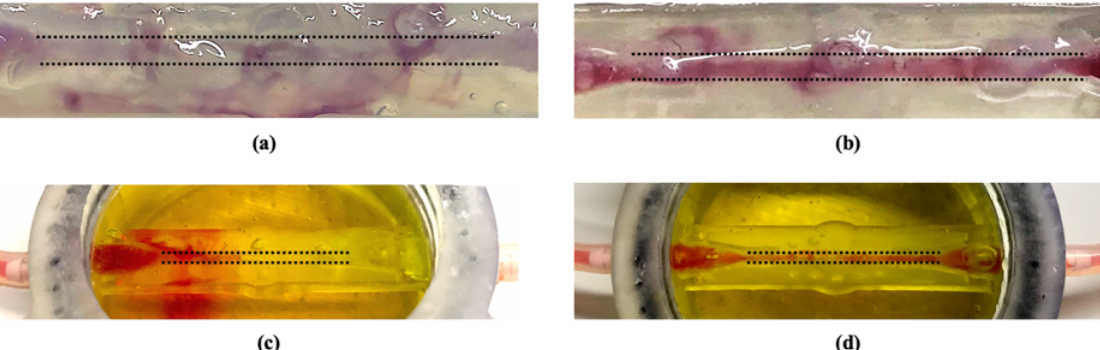
Figure 4. Hydrogels perfusion tests. The dotted line indicates where the channel is located. Comparison between alginate ( a ) and fibrin ( b ) capability to withstand the fluid passage at the same flow rate (1 mL / min); comparison between 3 mL / min ( c ) and 1.5 mL / min ( d ) as input flow rate values for fibrin hydrogel.